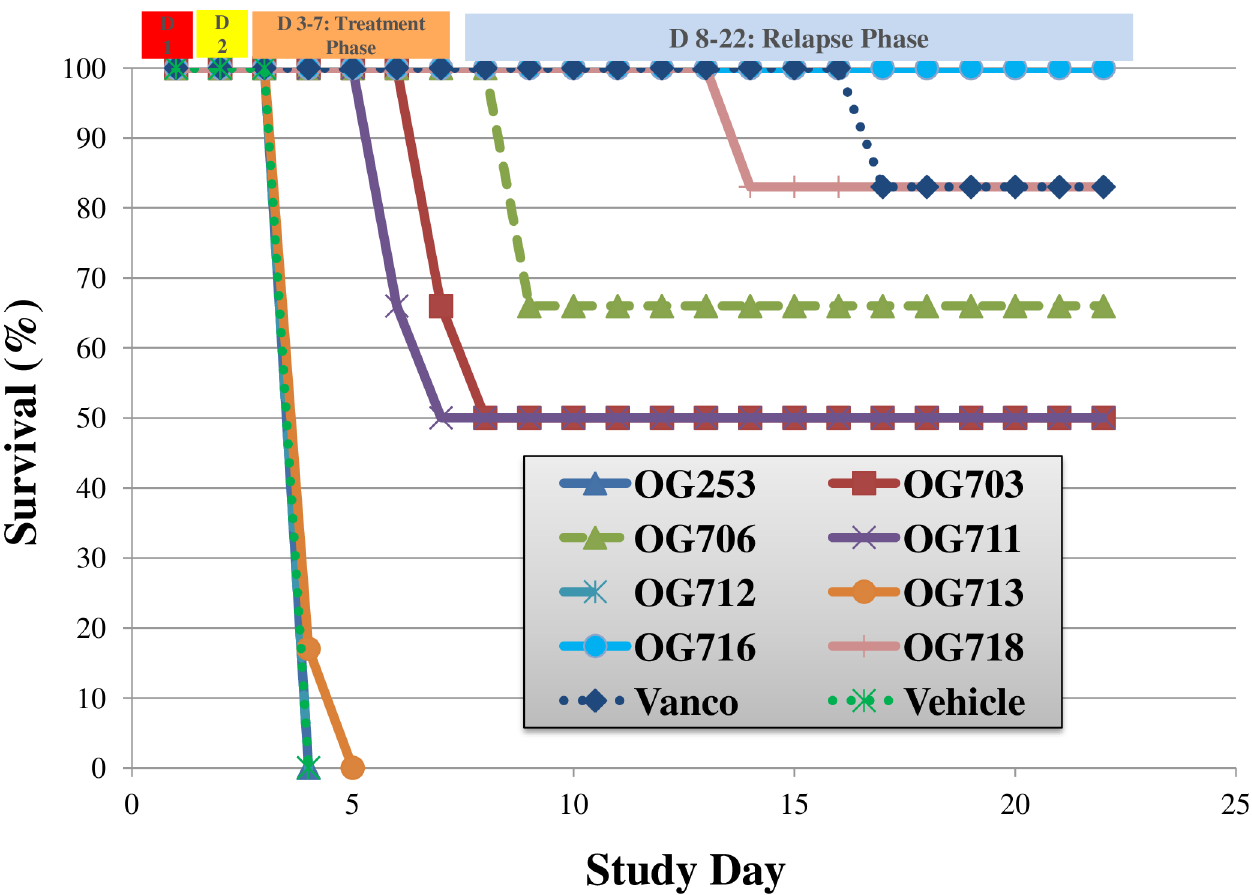
Fig 4. Efficacy of lead compounds assessed in vivo . Golden Syrian hamsters (N = 6 per group) were infected on Day 1 and received a single subcutaneous injection of Clindamycin (10 mg/Kg) on Day 2. Test compounds at 20 mg/Kg in 5% mannitol were administered by oral gavage 3 times per day (TID), starting on Day 2 at 18 hours after Clindamycin treatment, for 5 consecutive days (Days 2 through 6). Vancomycin (positive control) was administered at 20 mg/kg QD in parallel, and the infection control group was dosed with vehicle alone. See Materials and Methods for details.